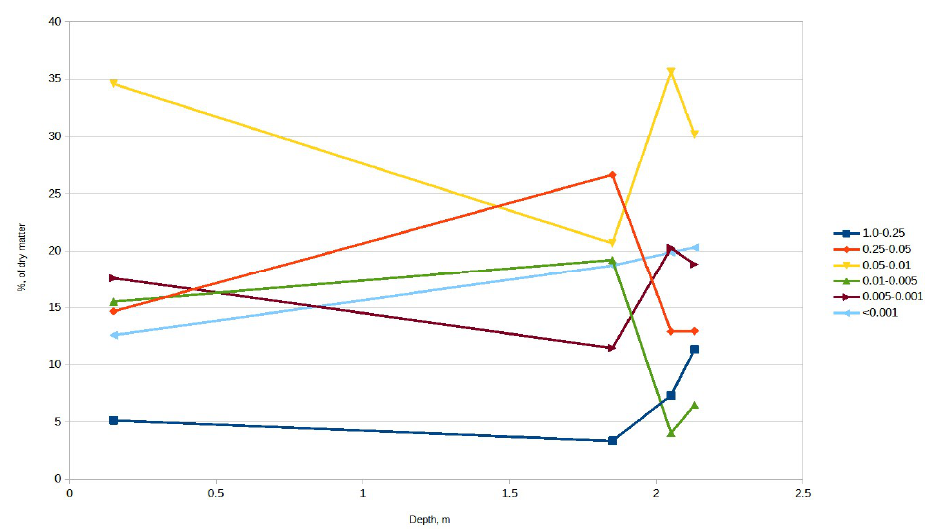
Figure 16. Mykolyna Broiaka. Granulometry in soil-section 1. Legend: sizes of particles, in mm. Analysis by O.O. Halahan. Elaboration—DK.